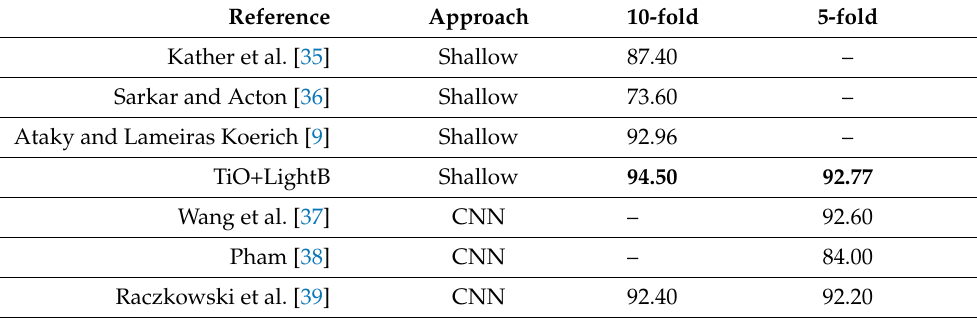
Table 7. Average accuracy (%) of shallow and deep approaches on the CRC dataset. The best results are marked in boldface.